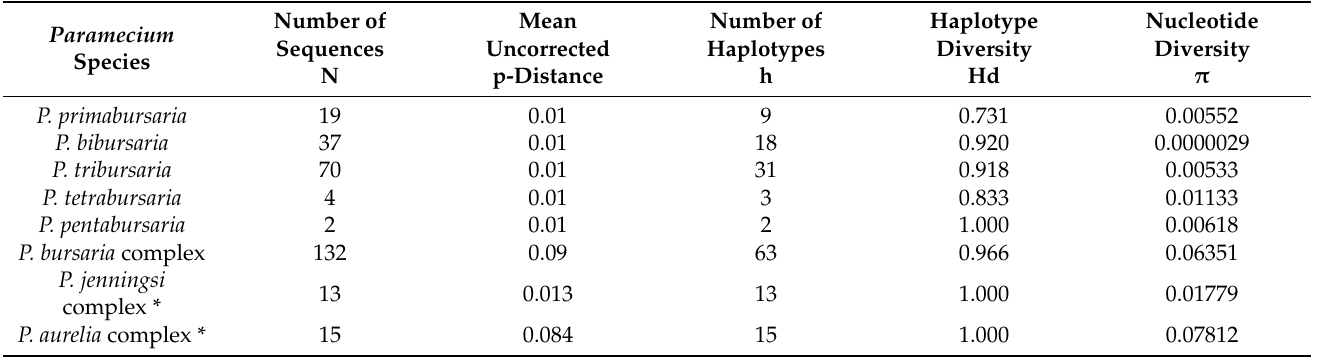
Table 1. DNA sequence variability of species from the Paramecium bursaria complex in comparison with the Paramecium aurelia and Paramecium jenningsi species